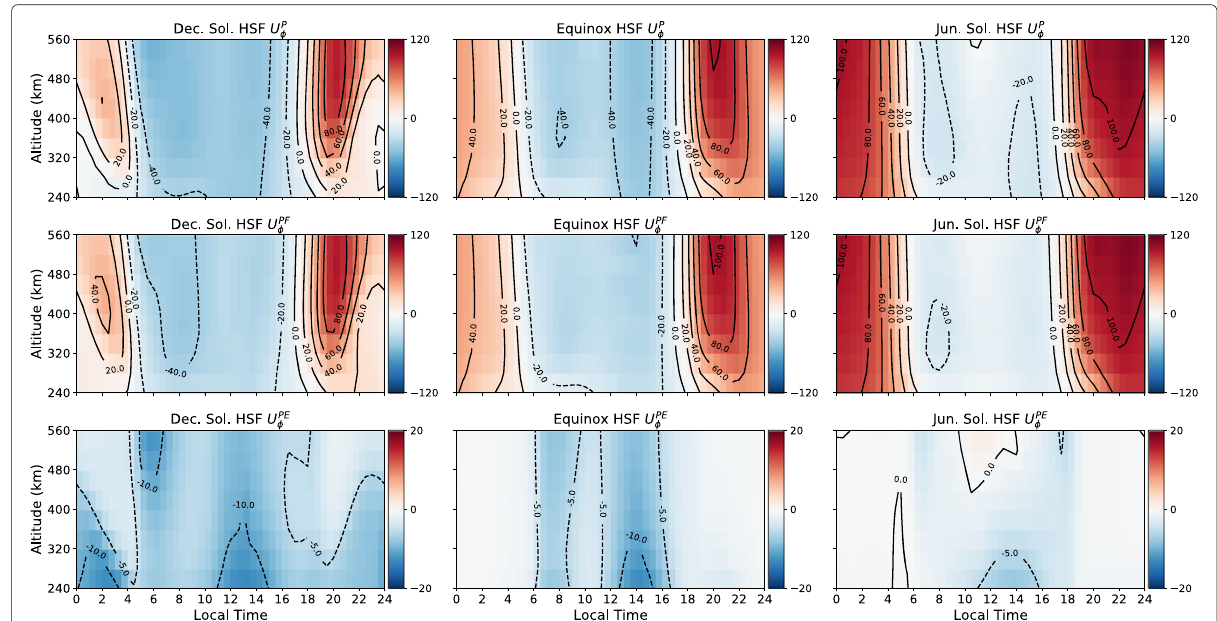
Fig. 12 The contributions from the E and F regions to the zonal wind dynamo during high solar flux (HSF) conditions. HWM14 was used to drive the zonal drift model